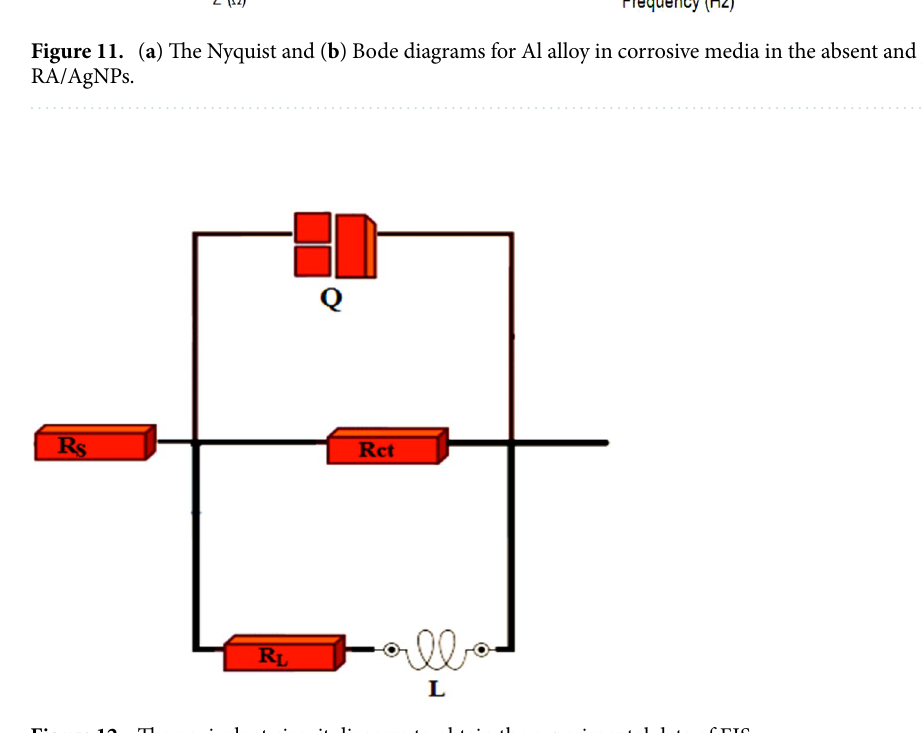
Figure 12. The equivalent circuit diagram to obtain the experimental data of